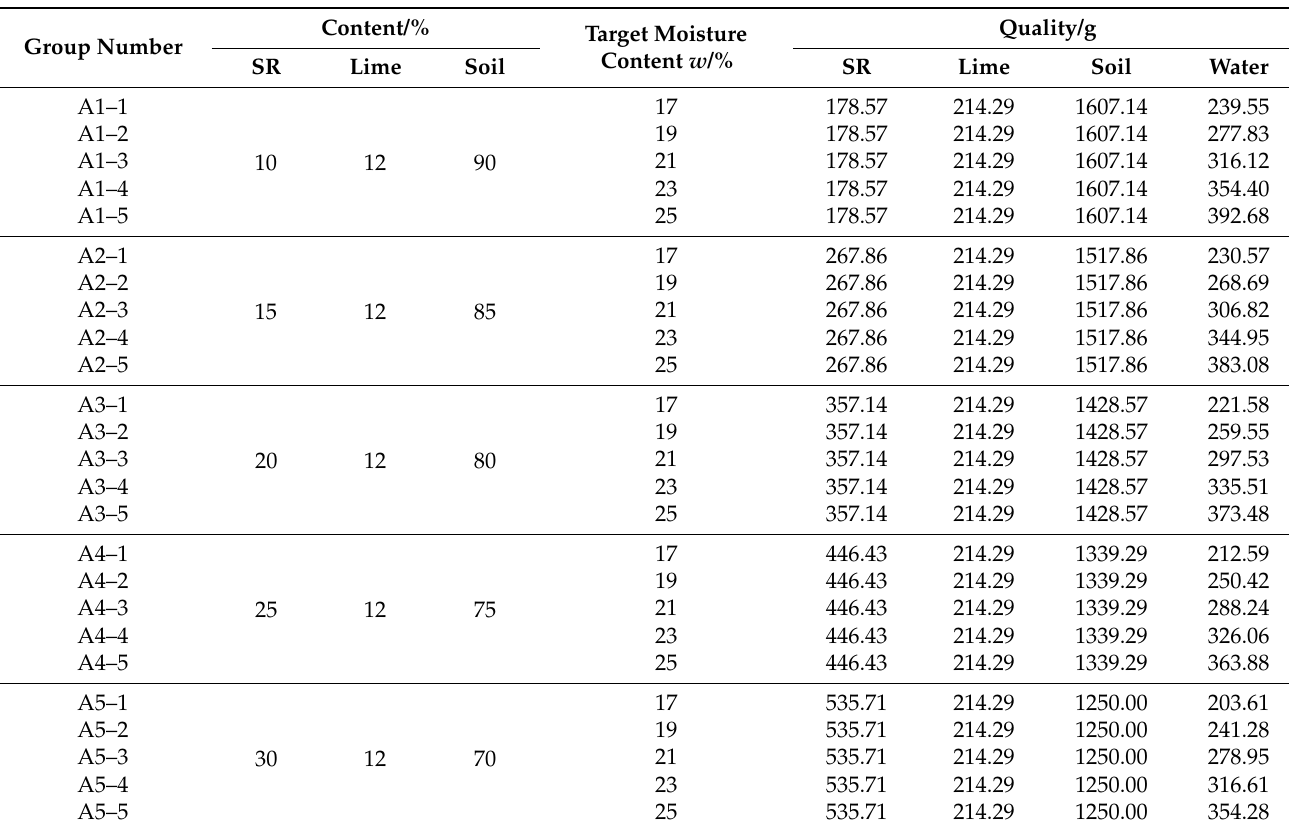
Table 3. Compaction test scheme and mass